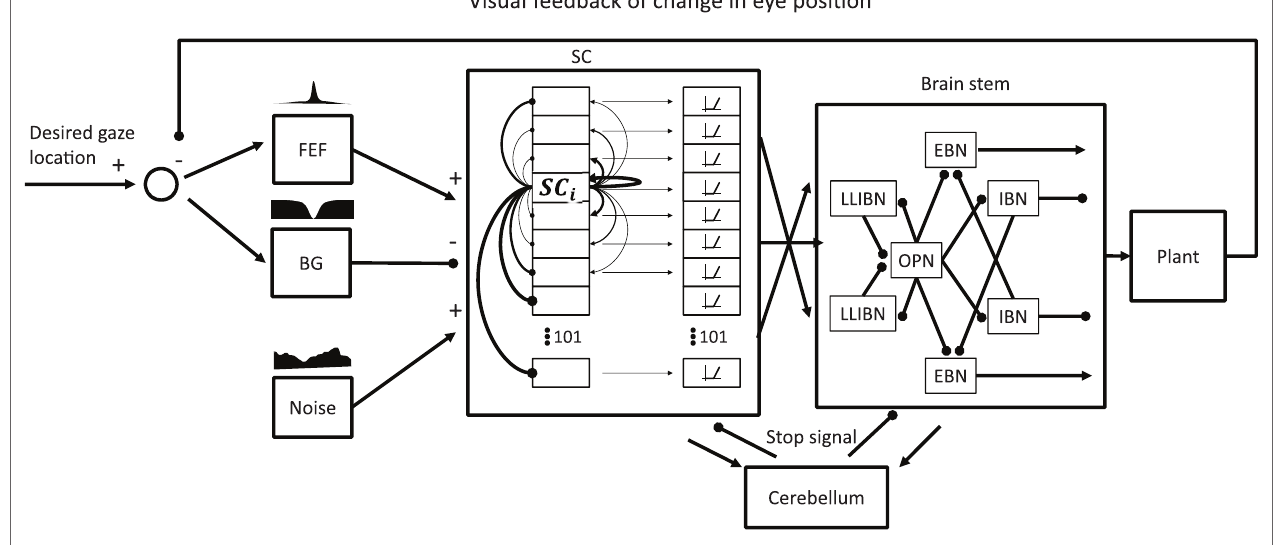
FigUre 3 | General model structure. The focus of the model is on the network formed by the superior colliculus (SC) and the omnipause neurons (OPNs) and burst neurons (BNs) in the brain stem and how they generate microsaccades in the presence of noise. Thus, the SC and the brain stem reticular formation are the only elements modeled as a network of neurons. All the other elements are “lumped” elements that just attempt to simulate a certain transfer function. The SC receives two complementary inputs indicating the desired gaze location in retinotopic coordinates, one excitatory from frontal eye field (FEF) and one inhibitory from basal ganglia (BG). It also receives a noise input that represents all the possible sources of noise the SC may receive. The SC is a network of 101 interconnected neurons with short-range excitatory connections and long-range inhibitory connections. The output of the SC that drives the BNs includes a nonlinearity that gives more weight to neurons firing more. The SC also drives the OPNs, especially when activity is centered around the center of the SC (representing the rostral pole). The model also includes a simple model of a cerebellar circuit that would produce a stop signal to reset both the SC and the BNs after a saccade. The output of the brain stem drives the eye plant that accounts for the mechanical properties of the eye. The resulting changes in eye position are fed back to the input of the model with a delay of 50